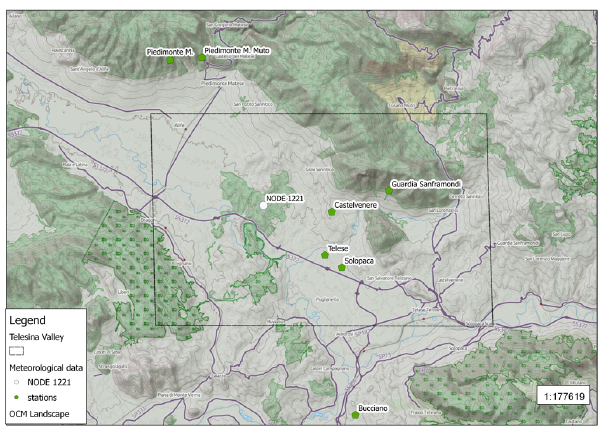
Fig. 2. Valle Telesina: location map showing the position of the node 1221 and of the ground meteorological